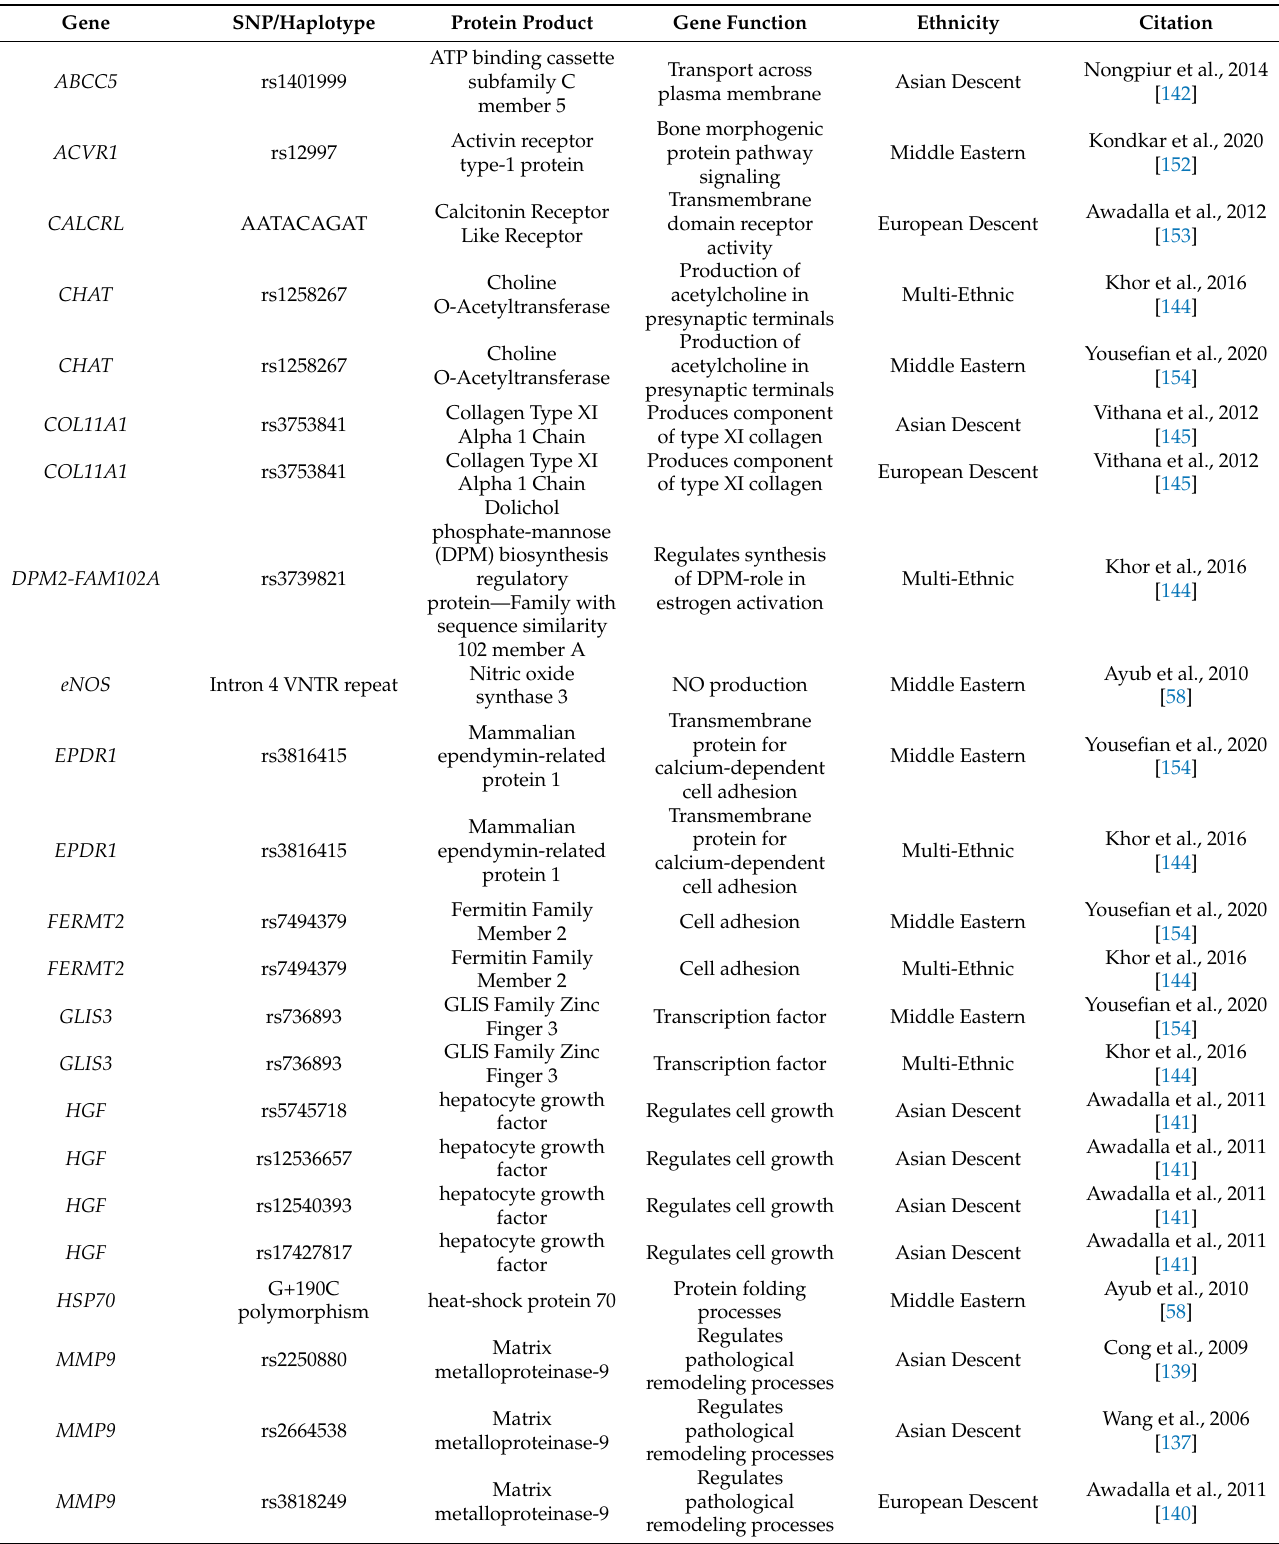
Table 2. Genes associated with primary angle closure glaucoma. SNP: single nucleotide